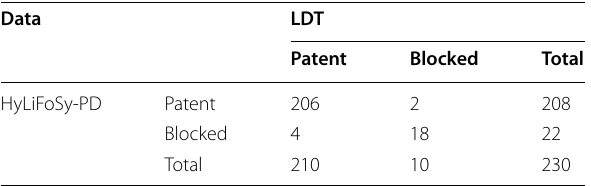
Table 2 Correlation between the results of HiLiFoSy with the results of